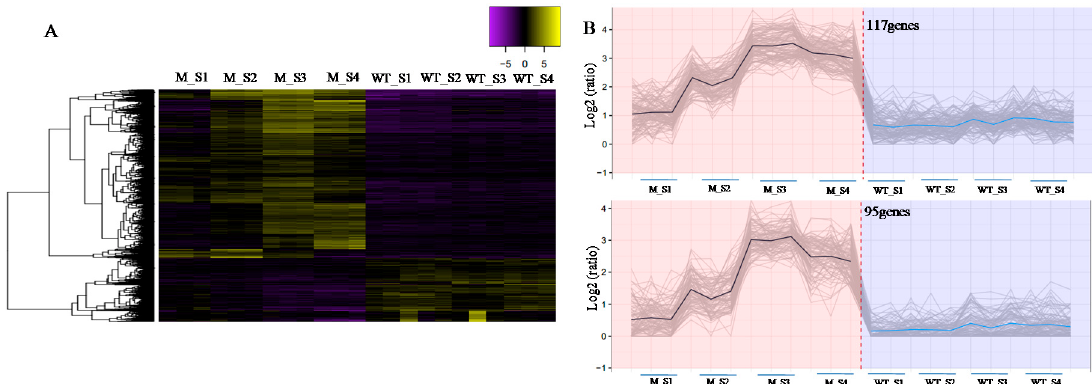
Figure 7. Clustering of DEGs between WT and m68 at different leaf senescence stages. ( A ) Hierarchical clustering of all DEGs; ( B ) The two subclusters represent 27 subclusters which had increased expression pattern in m68 and unchanged expression pattern in WT during leaf development. Gray lines show the relative expression levels of DEGs in the subcluster in WT and m68 at different leaf senescence stages. Black lines and Blue lines show the average values for relative expression in each subcluster. X -axis indicates m68 and WT at different leaf senescence stages. Y -axis indicates the relative expression level.